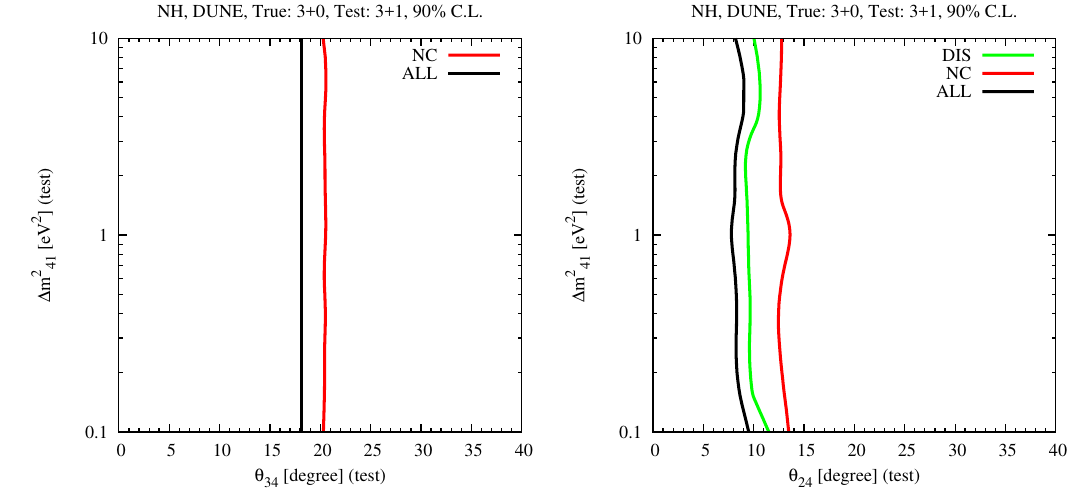
Figure 10 . 90% ((cid:1) (cid:31) 2 = 4 : 61) C.L. contour plots for 3+1 exclusion in the test (cid:1) m 2 (left) and test (cid:1) m 2 -test (cid:18) 24 space (right). The results are for the DUNE experiment with 3.5 years 41 each of neutrino and anti-neutrino running. The true case has been taken to be 3+0 and the test to be 3+1. In the left panel, we show results with the NC data, and NC and CC data combined (\ALL"). In the right panel, we show results with the NC data, the disappearance data (\DIS") and the NC and CC data combined